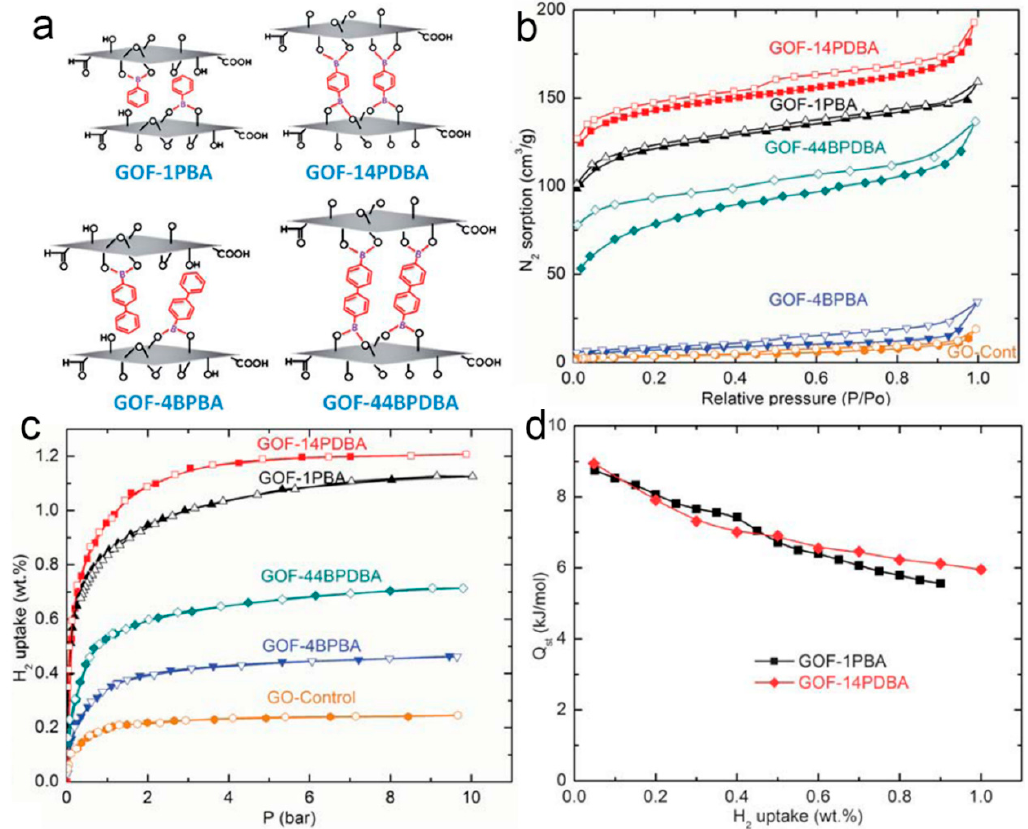
Figure 10. A structural illustration of graphene oxide frameworks (GOFs) with various types of phenylboronate pillaring units ( a ); nitrogen adsorption (filled) and desorption (empty) isotherms of GOFs measured at 77 K ( b ); hydrogen adsorption isotherms of GOFs at 77 K ( c ); isosteric heat of GOF-1PBA and GOF-14PDBA for capturing H 2 ( d ). Reprinted with permission from [122]. Copyright 2011, The Royal Society of Chemistry.